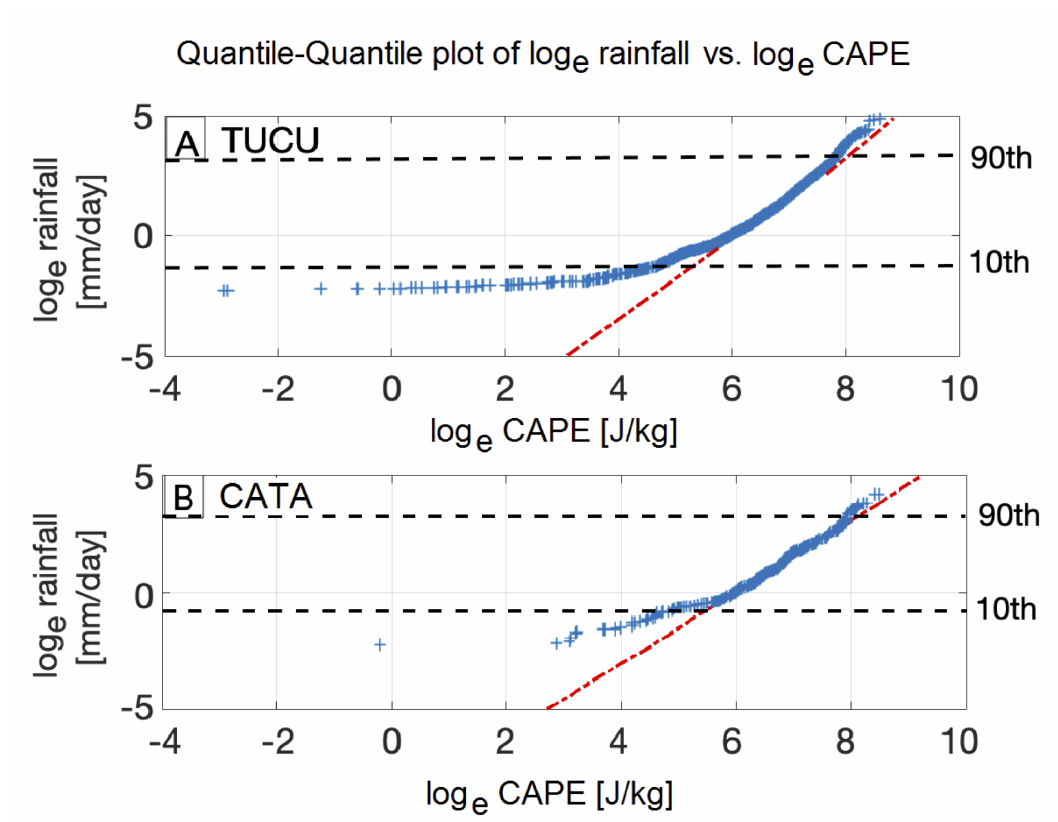
Figure 7. Quantile–Quantile plot on log e scale of rainfall vs. log e scale of CAPE essentially shows that most of the data are well behaved within the assumed relation for both stations ( A ) for TUCU and ( B ) for CATA. Below the 10th percentile, rainfall and CAPE do not follow an identical distribution at both stations. Black dashed lines indicate the rainfall percentiles (the 10th and 90th